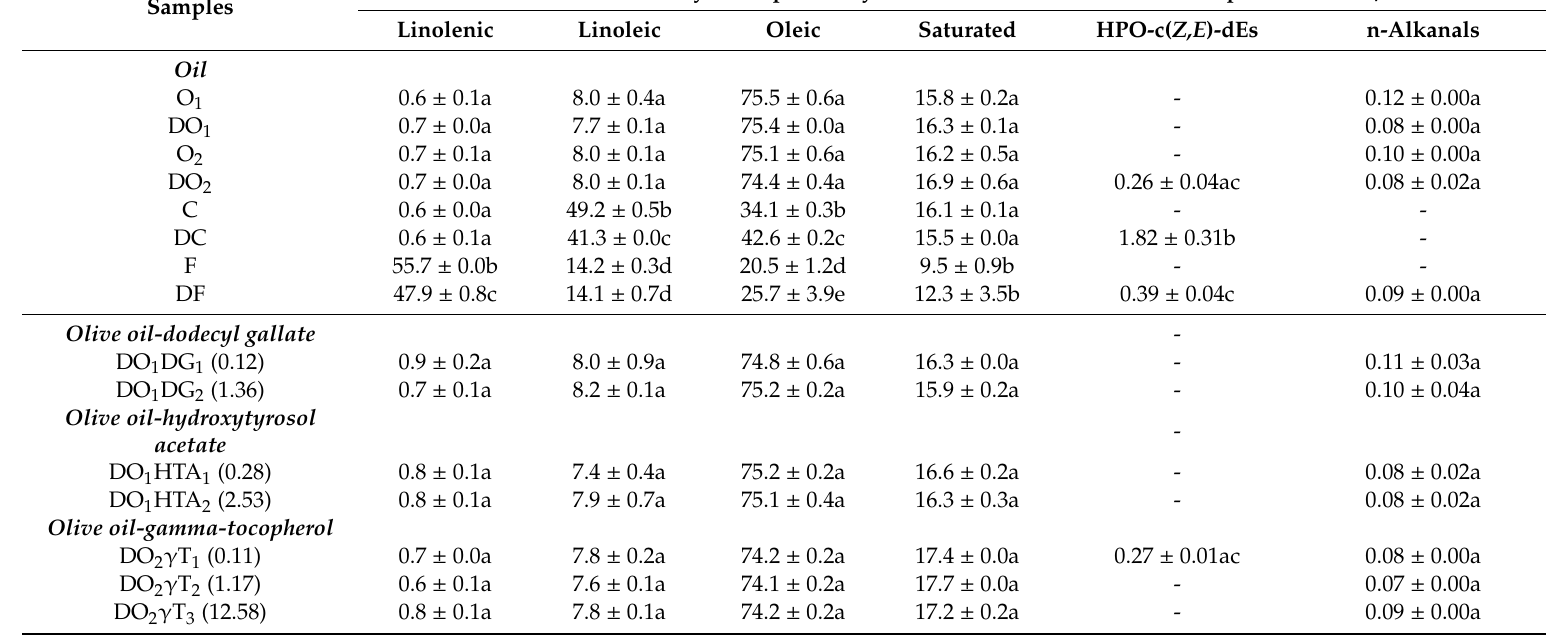
Table 2. Molar percentage of the main acyl groups plus fatty acids (AG + FA), in relation to the total moles of all kinds of AG and FA, in olive oils (O 1 and O 2 ), in corn oil (C) and in virgin flaxseed oil (F), in the digestates of these oils (DO 1 , DO 2 „ DC and DF) and in those of the samples enriched with dodecyl gallate, hydroxytyrosol acetate and gamma -tocopherol (DO 1 DG 1 , DO 1 DG 2 , DO 1 HTA 1 , DO 1 HTA 2 , DO 2 γ T 1 , DO 2 γ T 2 ,and DO 2 γ T 3 ) whose level of enrichment in phenolic compounds is given in brackets in mmol / mol (AG + FA) O . Concentration of some oxidation compounds, expressed by mmol per mol of AG + FA in the above samples. Di ff erent letters within each column indicate statistically significant di ff erences among the samples ( p < 0.05). Data of corn and virgin flaxseed oils and of their digestates were taken from previous studies